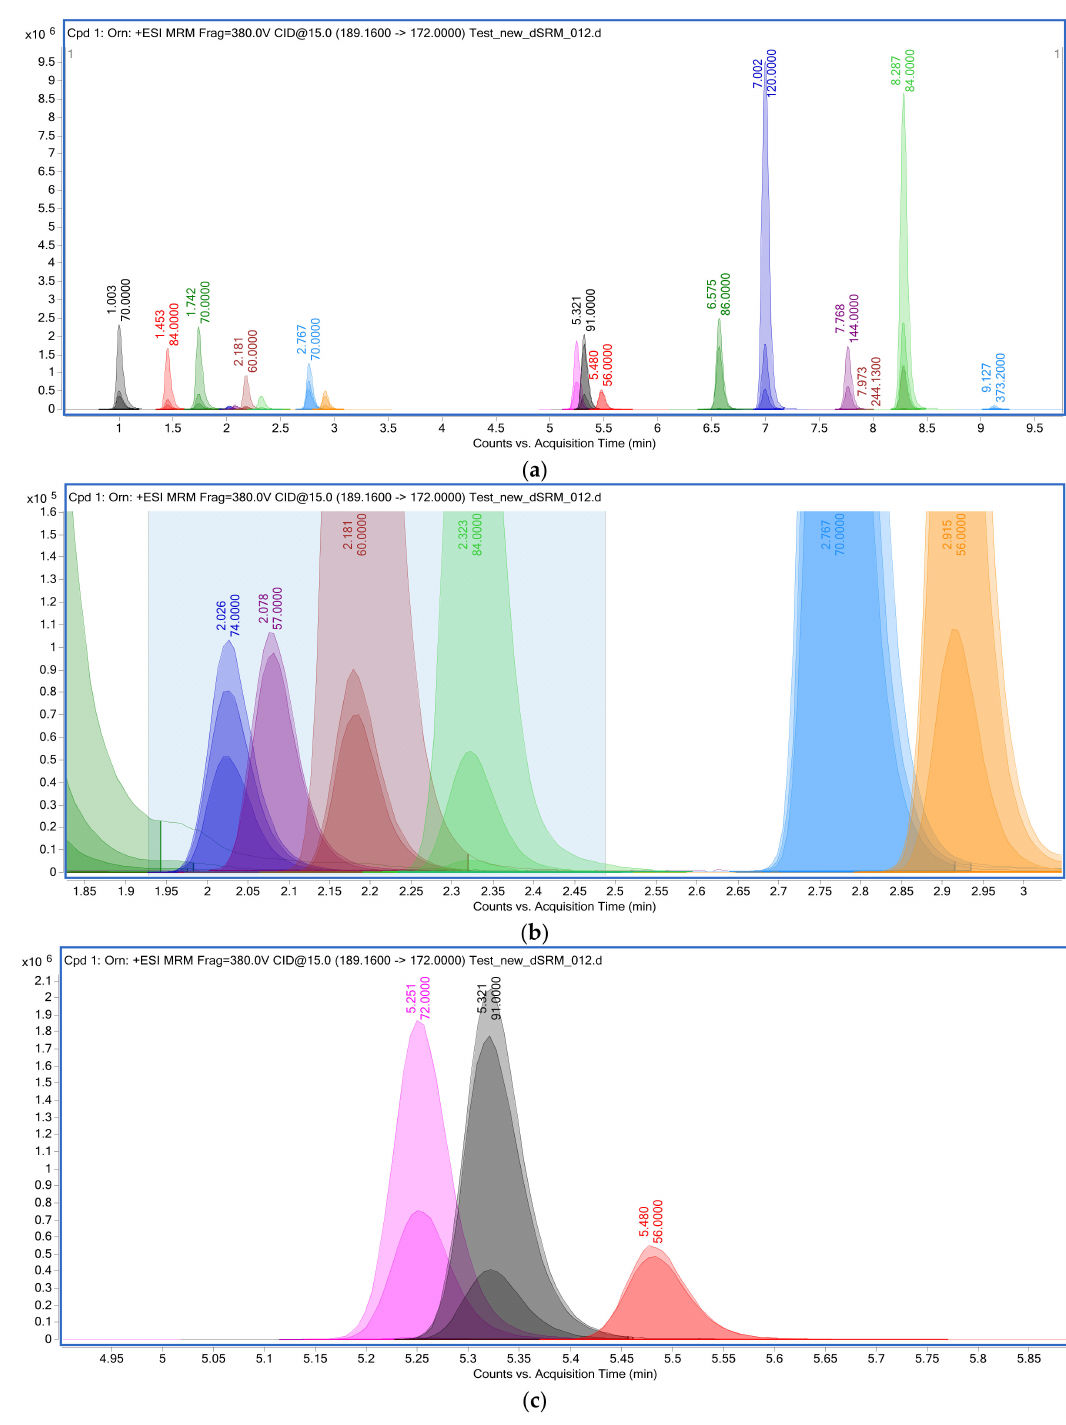
Figure 1. Chromatogram of esterified amino acids by isolated XIC/EIC ion current under detection conditions by monitoring multiple reactions of the formation of SRM fragment ions. Top panel ( a ) shows a general view of the chromatogram in the metabolite separation interval from 0 to 9.5 min. Middle panel ( b ) shows an enlarged gradient region from 1.9 to 2.5 min, corresponding to column retention times of asparagine RT = 2.026 min, glycine RT = 2.078 min, serine RT = 2.181 min, and glutamine RT = 2.323 min. The lower panel ( c ) shows an enlarged section of the gradient interval from 4.95 to 5.8 min, corresponding to the retention time on the column of valine RT = 5.251 min, tyrosine RT = 5.321 min, and methionine RT = 5.480